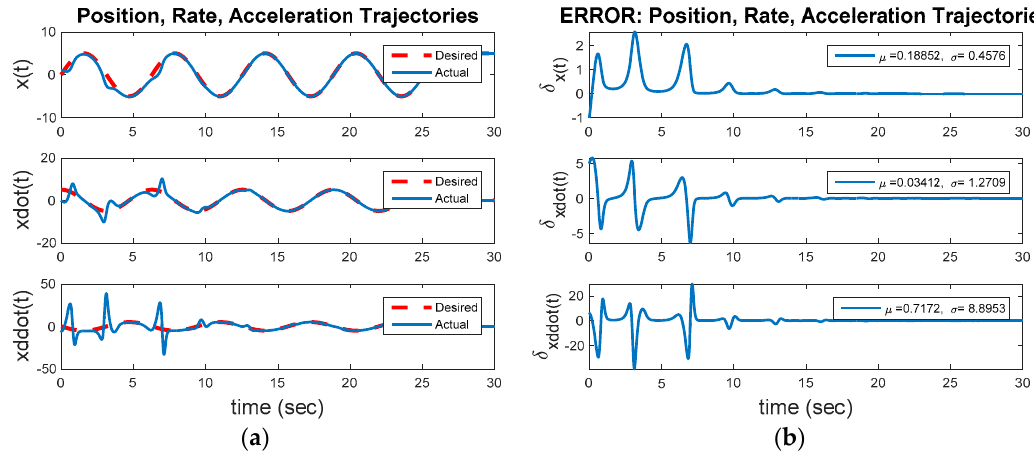
Figure 8. Trajectory comparison and errors associate with Figure 7: ( a ) displays trajectory comparison; and ( b ) trajectory.